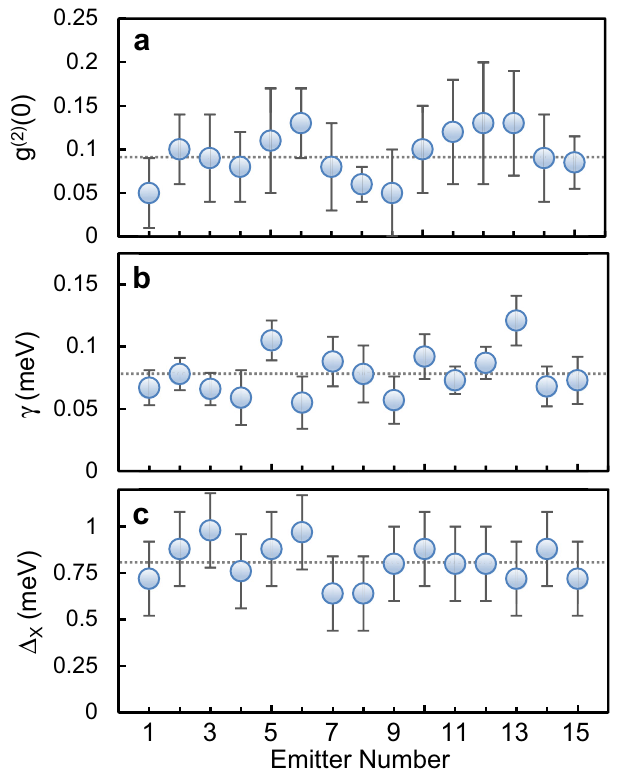
Fig. 4 Statistics of single-emitter properties. a g (2) (0) distribution. Average g (2) (0) is 0.08, which demonstrates the high purities achieved by this method. b Homogenous linewidth distribution with 75 μ eV average. c Zero- fi eld doublet-splitting showing the reproducibility of the method in engineering SPEs with similar characteristics. Horizontal dashed lines denote the average of measurements. Error bars denote the standard deviation from fi tting the